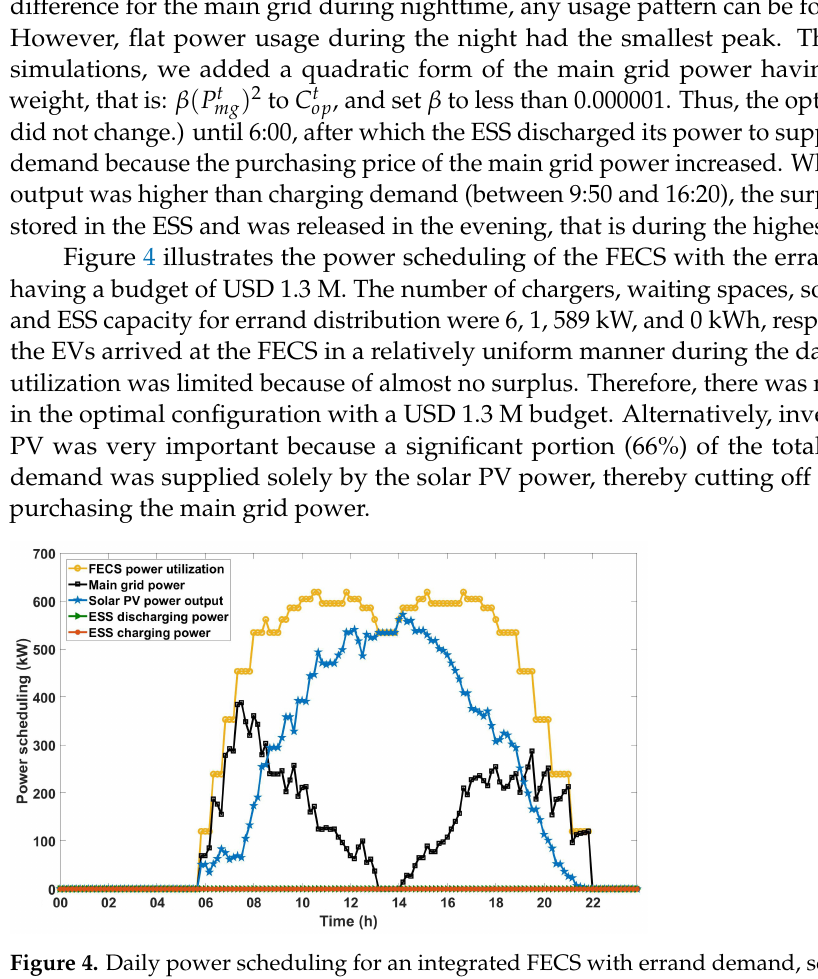
Figure 4. Daily power scheduling for an integrated FECS with errand demand, solar PV (589 kW), and ESS (0